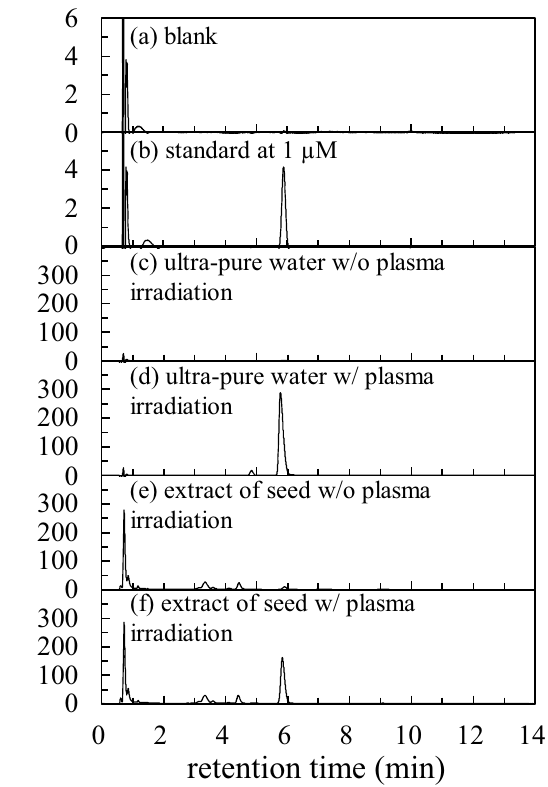
Figure 4. MWD chromatograms of 210 nm of ( a ) blank, ( b ) standard solution of NO 3 − at 1 µM of concentration, ultra-pure water ( c ) without plasma irradiation and ( d ) with plasma irradiation for 300 s, and extract of seed ( e ) without plasma irradiation and ( f ) with plasma irradiation for 5